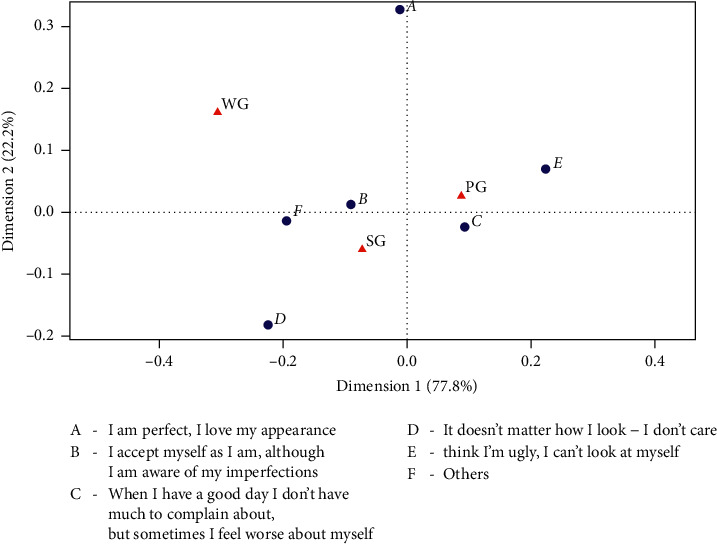
The analysis of correspondence regarding self-esteem and dysmenorrhea among the studied female respondents. The questions are included in Appendix A. PG, women with dysmenorrhea during every cycle, SG women with dysmenorrhea occasionally, and WG, women without dysmenorrhea.